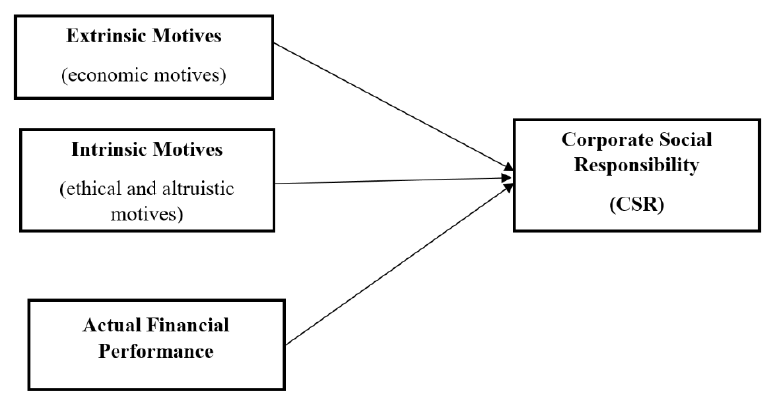
Figure 1. Theoretical framework.